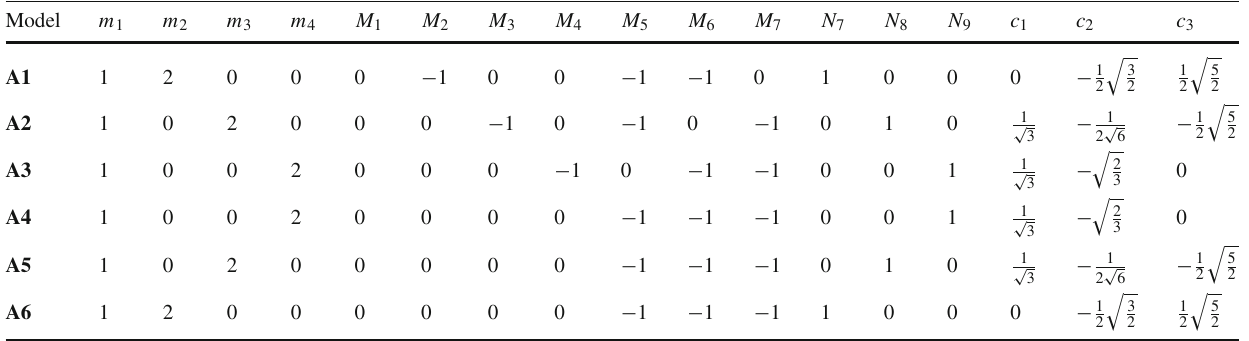
Table 5 MSSM flux solutions along with the resulting c i ’s. For this class of models (Class A), singlets come in pairs ( M ij = M ji )